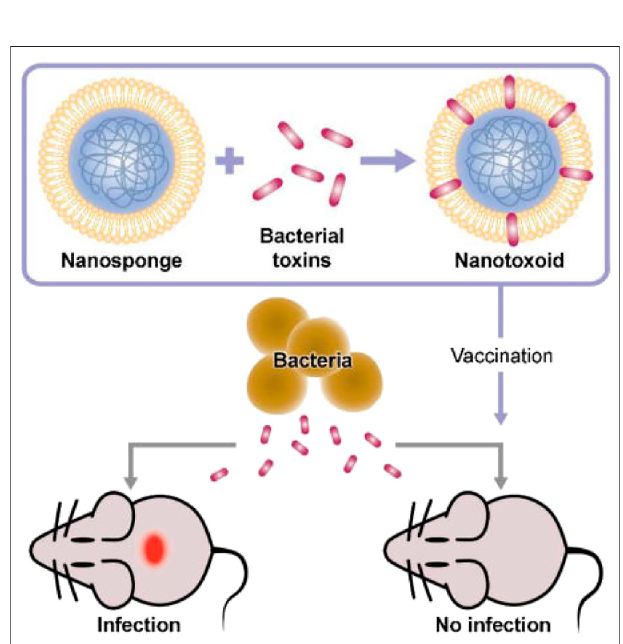
FIGURE 8 | Concept of toxin-NPs (Reproduced from Angsantikul et al., 2018).